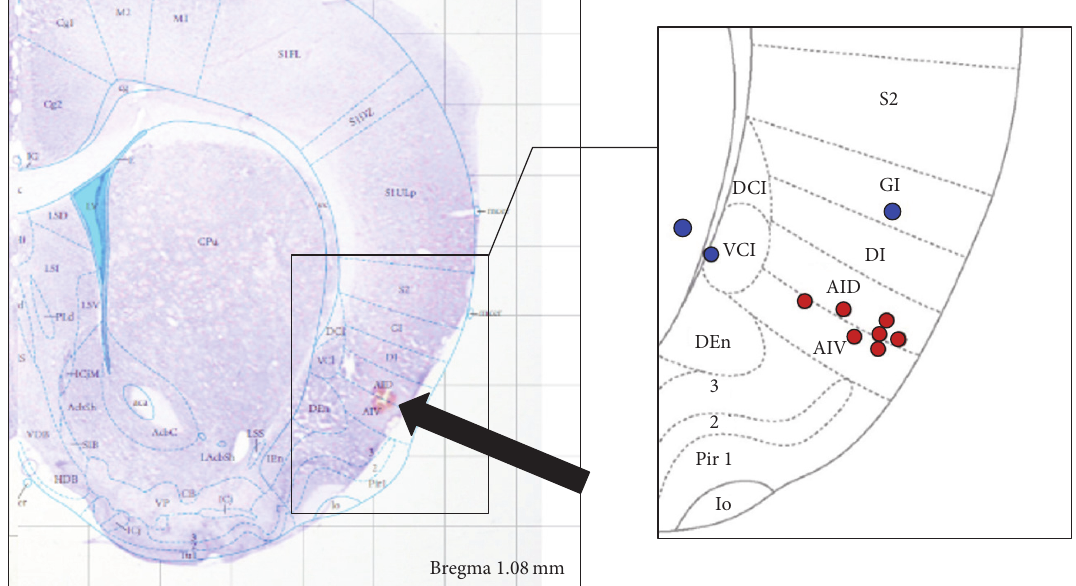
Figure 2: Histological verification of rostral agranular insular cortex (RAIC) lesions with fusing Mai atlas. Data from red dots ( 𝑛 = 7 ) were analyzed in this study. Blue dots were excluded from data